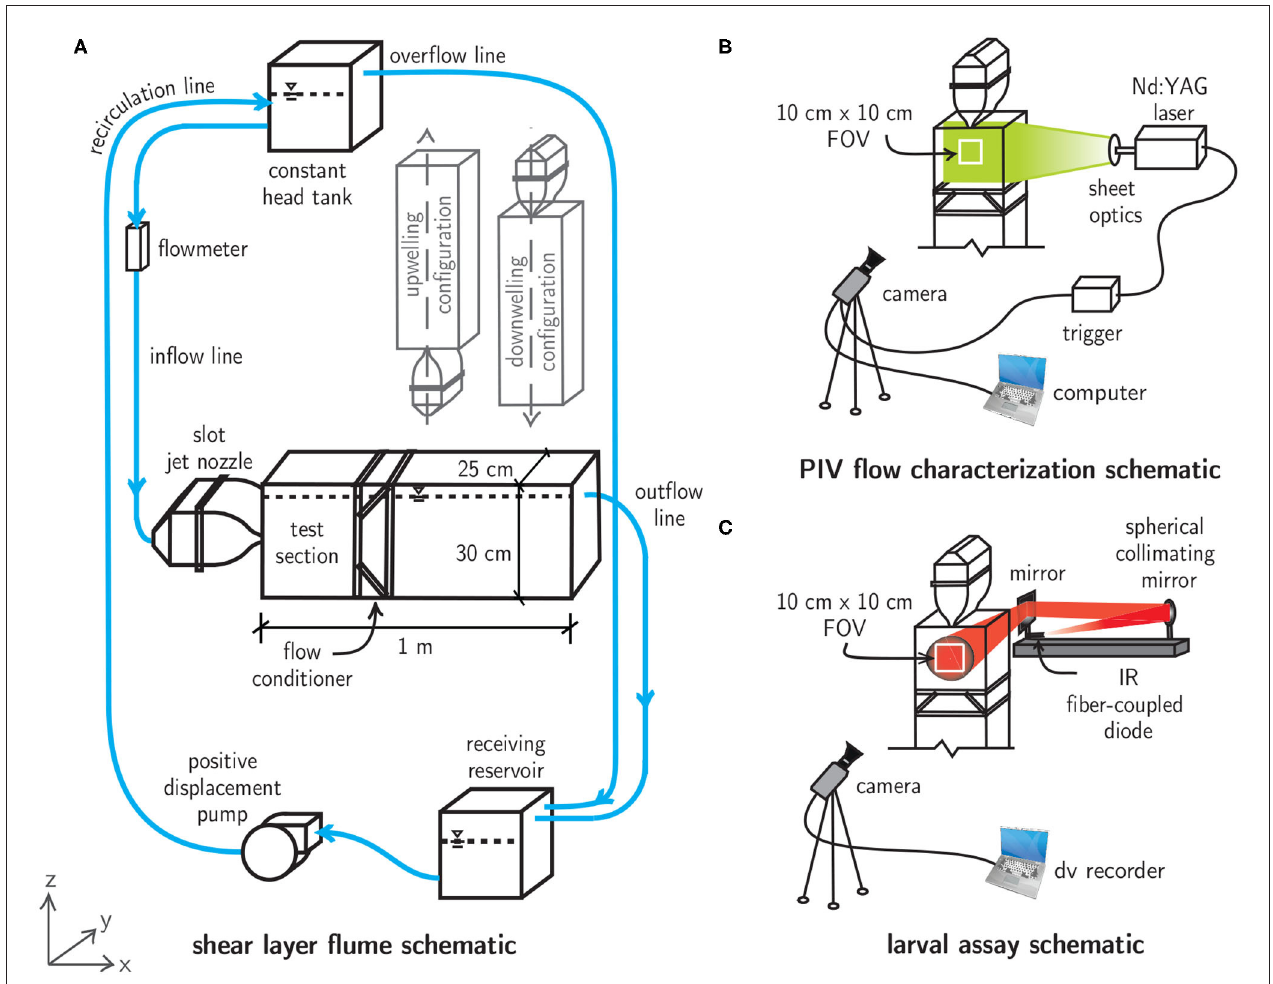
FIGURE 4 | (A) Shear layer flume schematic featuring a main flume section that can be oriented in upwelling, downwelling, or horizontal flow configurations. The water levels in the main flume, constant head tank, and receiving reservoir are indicated by dashed lines and the free surface symbols. (B) Particle image velocimetry (PIV) schematic for flow characterization. (C) Collimated, infrared (IR) shadowgraph system for larval shear layer behavioral